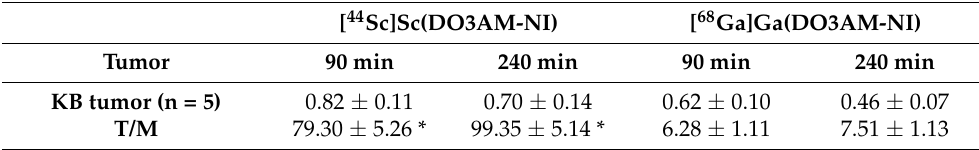
Table 3. Ex vivo evaluation of [ 44 Sc]Sc(DO3AM-NI) and [ 68 Ga]Ga(DO3AM-NI) uptake (%ID/g) in KB tumors 13 ± 1 days after subcutaneous tumor induction. Significance level between the tumor- to-muscle ratios (T/M) of [ 44 Sc]Sc(DO3AM-NI) and [ 68 Ga]Ga(DO3AM-NI) at 90 and 240 min: p ≤ 0.01 (*). %ID/g values are presented as mean ± SD.